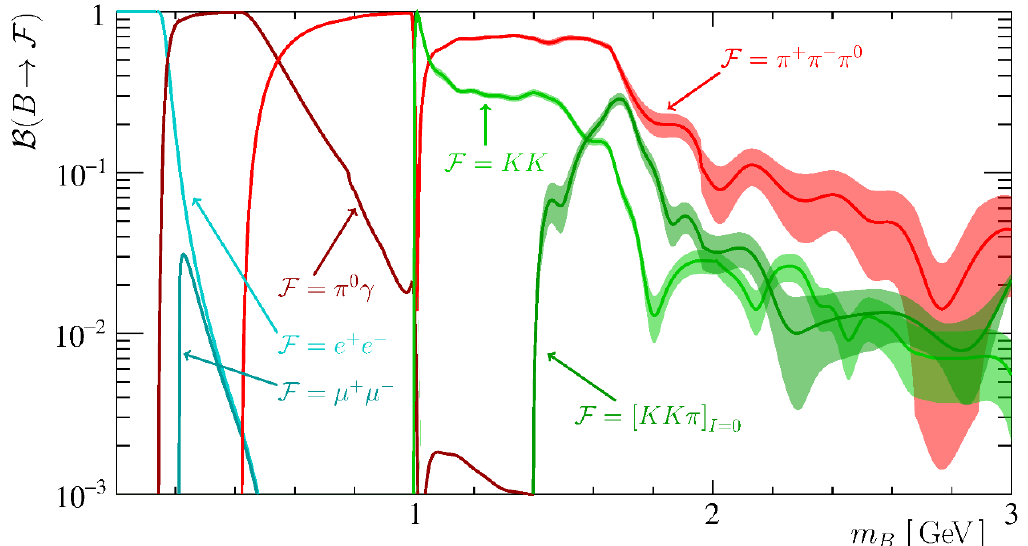
Figure 10 . Decay branching fractions for the B boson assuming a kinetic-mixing parameter " = eg B = (4 (cid:25) ) 2 . The error bands shown for the (cid:12)nal states (cid:25) + (cid:25) (cid:0) (cid:25) 0 , KK [ KK(cid:25) ] (i.e. the isoscalar component of the KK(cid:25) (cid:12)nal state) are due to the limited experimental I =0 knowledge of the e + e (cid:0) cross sections. In addition, the use of VMD and U(3) symmetry ! F introduces roughly a 20% uncertainty on all hadronic decay